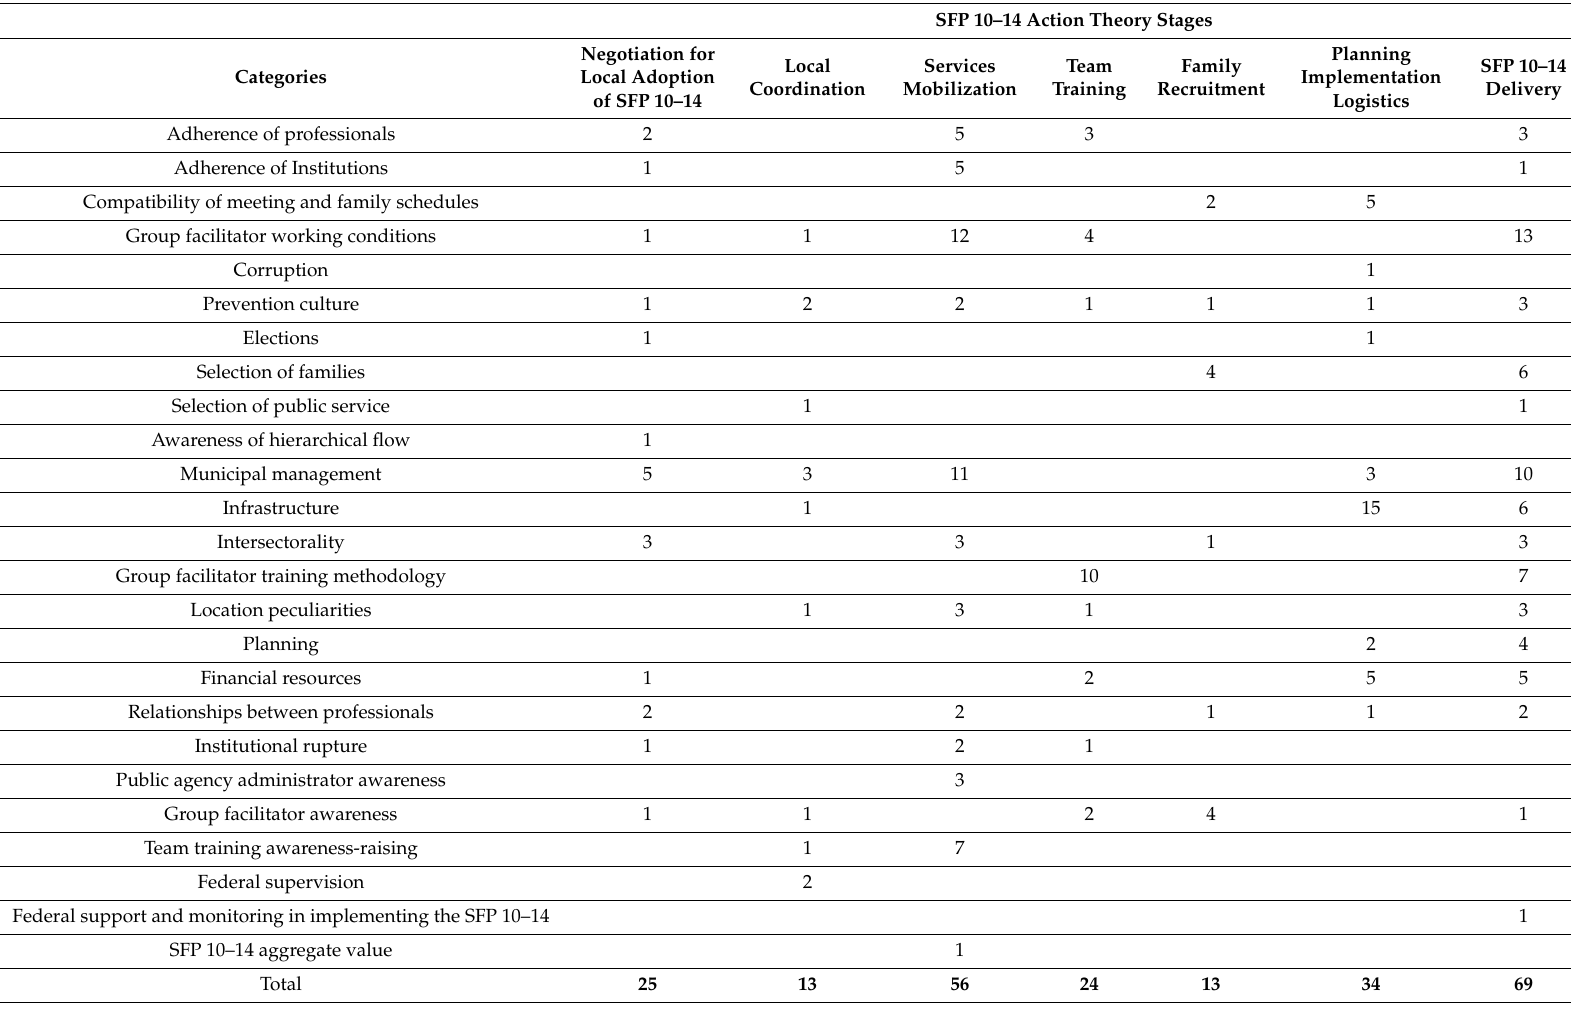
Table 5. Frequency of topics pointed out as barriers to the SFP 10–14 implementation process by the stage of the action theory in